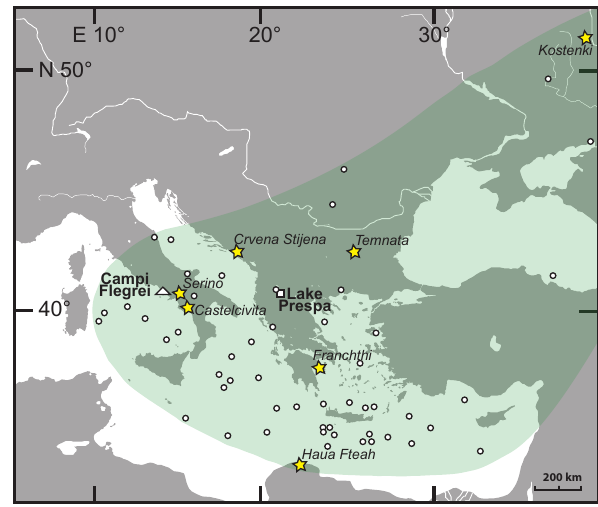
Fig. 9. Map showing the distribution of the Campanian Ign- imbrite/Y5 tephra (green field), based on terrestrial/marine (white circles) and archaeological (yellow stars) sites; modified after Fedele et al. (2003, 2008). Archaeological sites refer to Vitaliano et al. (1981), Paterne (1992), Sinitsyn (2003), Giaccio et al. (2006), Lane et al. (2011b) and Morley and Woodward